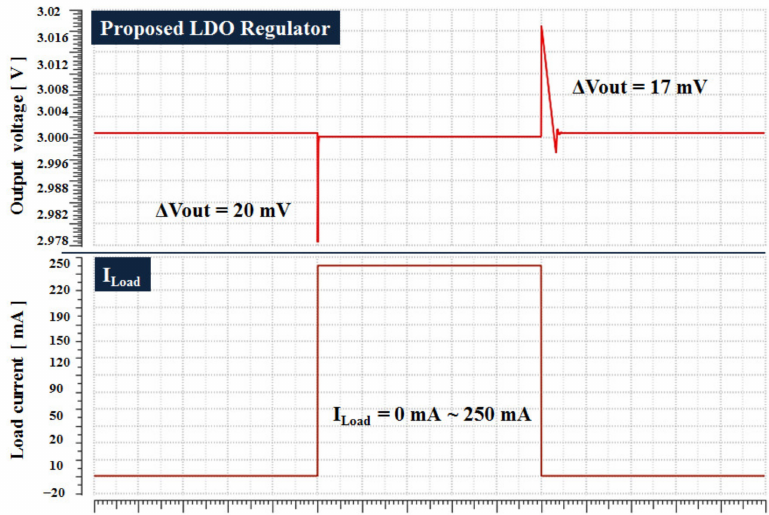
Figure 7. Results of simulation of transient response characteristics of the proposed LDO regulator.